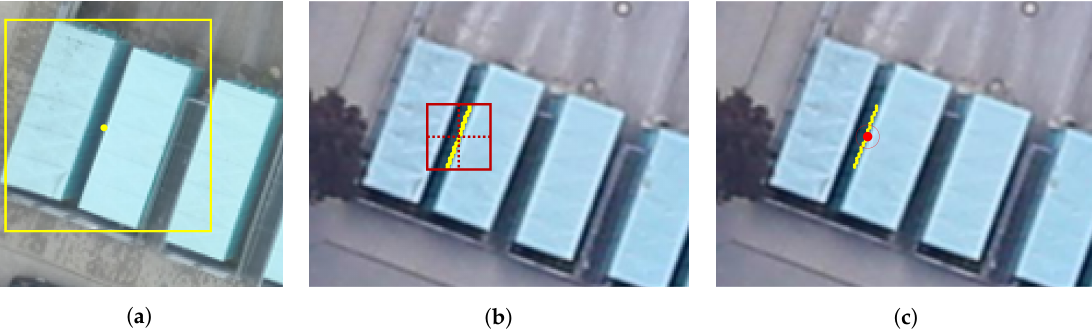
Figure 9. Refinement and duplicate elimination of geometric correct matches. ( a ) One feature point in the UAV image (yellow dot) and its template size (rectangle); ( b ) corresponding geometric inliers (yellow dots) in the aerial image and size of the search window for one match (red rectangle); ( c ) all geometric inliers will share the same optimized pixel location after refinement (red